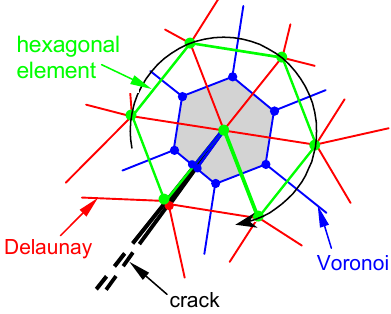
Figure 10. The regular Voronoi polygon generated on the crack tip.